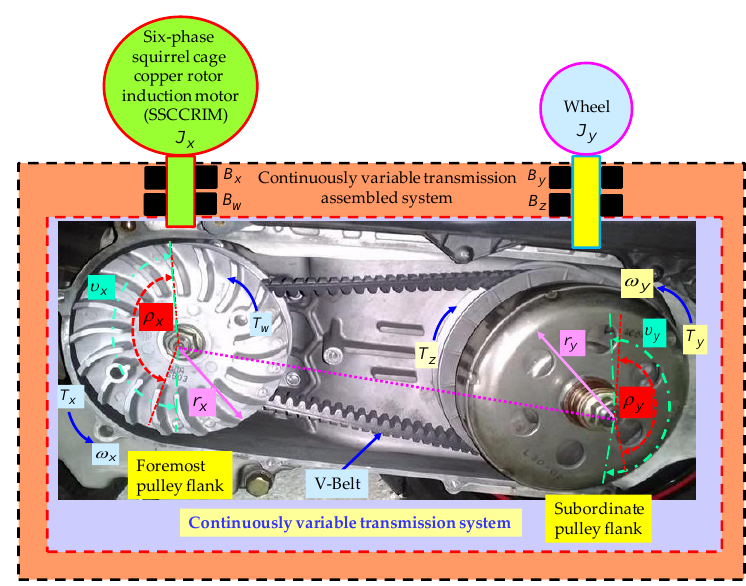
Figure 1. Conformation of the SSCCRIM and the continuously variable transmission assembled system.